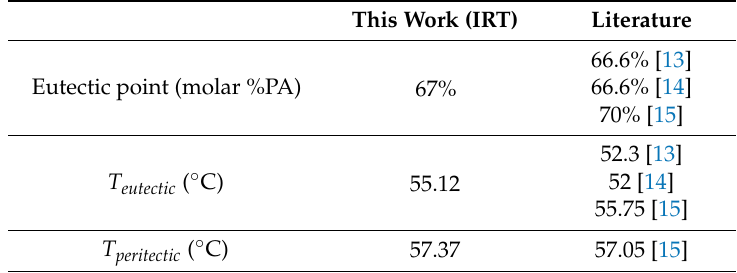
Table 3. Comparison between experimental and literature properties of the PA–SA binary